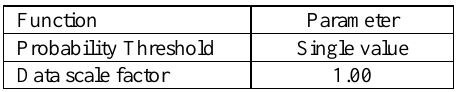
Table 3. Description of the adjusted parameters with the